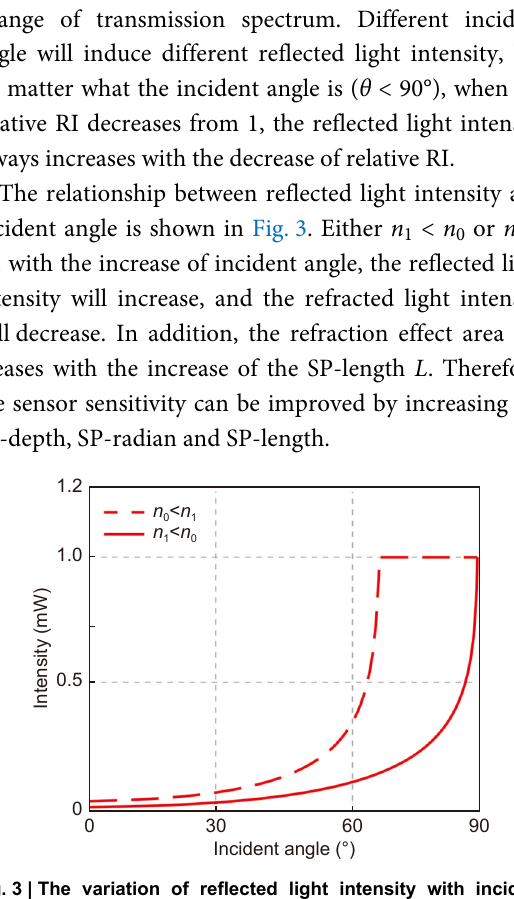
Fig. 3 | The variation of reflected light intensity with incident angle; the dotted line indicates n 01 = 0.9, and the solid line indic- ates n 01 = 1.1.